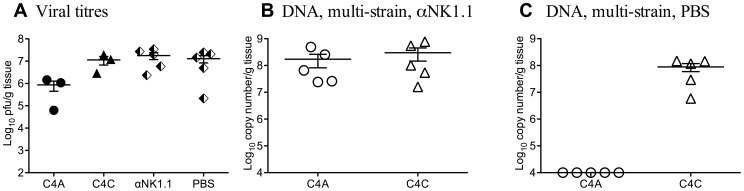
Within-host competition in B6 mice is dependent on NK cells.To assess the role of NK cell on within-host competition, NK cells were depleted from B6 mice by i.p. injection of 150 µg of the monoclonal antibody PK136 at day −1, 0 and then every 5 days until day 15 p.i. On day 0 mice were inoculated i.p. with 1×104 pfu of either a single MCMV strain (closed symbols) or a total of 1×104 pfu of a mixed inoculum of equal proportions of C4A and C4C (half filled diamonds - plaque assay or open symbols – strain specific PCR). A. Titers of infectious virus were determined by plaque assay in salivary glands of non-manipulated mice infected with either C4A or C4C (closed symbols), or in PK136 (anti-NK1.1) or PBS treated mice co-infected with C4A and C4C (half filled diamonds). B. Viral DNA levels in B6 mice treated with PK136 (anti-NK1.1) and co-infected with C4A and C4C. Note both C4A and C4C DNA were detectable following NK cell depletion. C. Viral DNA levels in B6 mice treated with vehicle (PBS) and co-infected with C4A and C4C. Note competition was retained, with C4A DNA undetectable in the salivary glands. The x-axis represents the limit of detection for plaque assays (100 pfu/g of tissue) and the multiplex qPCR (1×104 copy number/g of tissue), n = 5 mice per group.